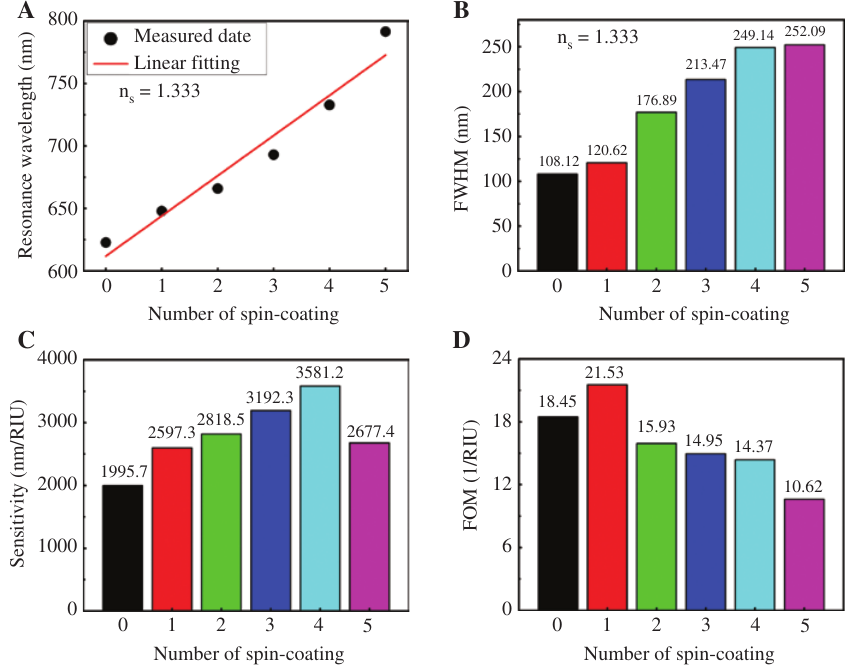
Figure 7: The performances of the presented sensor. The changes of (A) Resonance wavelength, (B) FWHM, (C) sensitivity and (D) FOM for SPR sensor corresponding to different GeSe spin coating times from 0 to